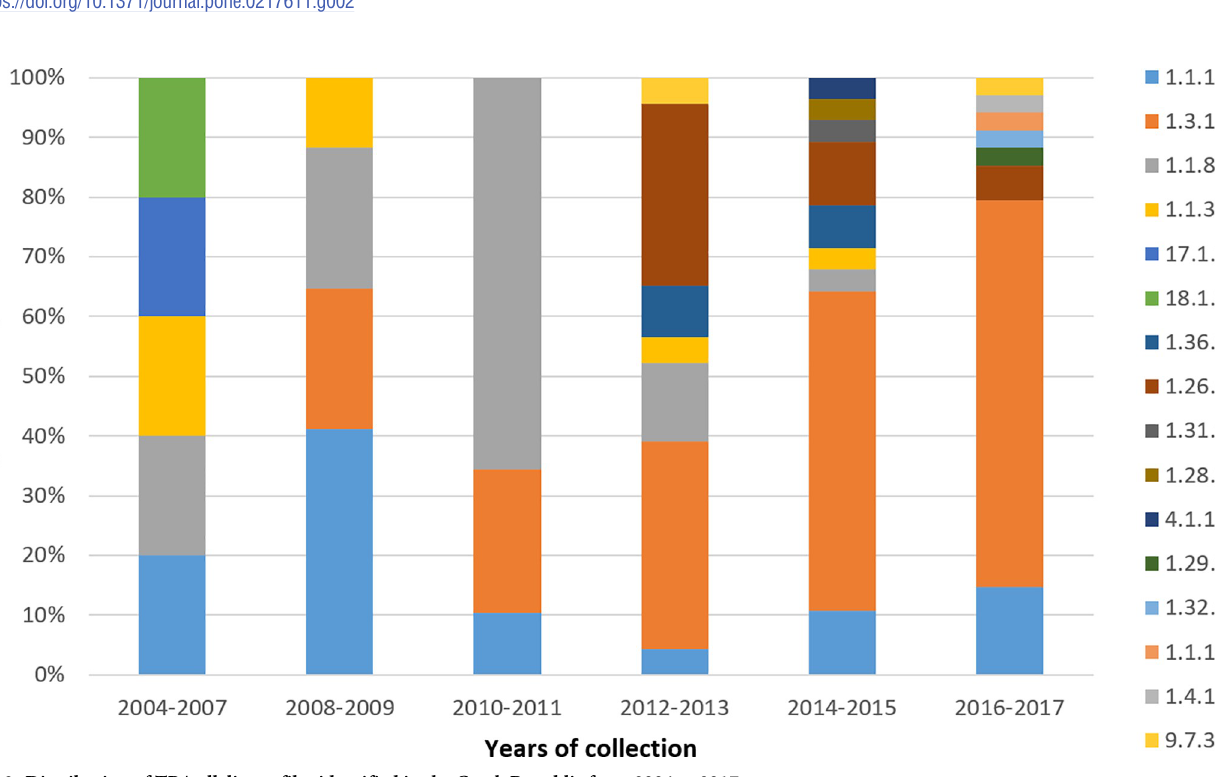
PLOS ONE | https://doi.org/10.1371/journal.pone.0217611 May 31,